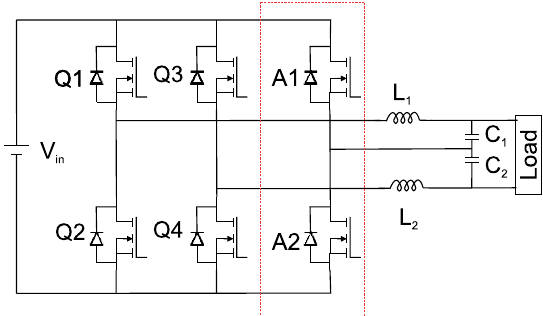
Figure 13. SRC control configuration proposed in [87].